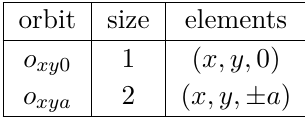
Table 8. Orbit types for the frame with d ref = ( n 1 , n 2 , 0) , where n 1 and n 2 are distinct, nonzero integers. Here a > 0 , while x and y are unconstrained integers that can be equal.